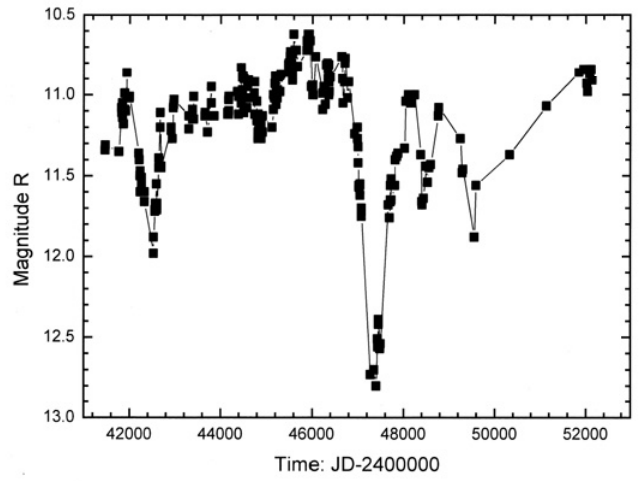
Fig. 9. Observed light curve of V1983